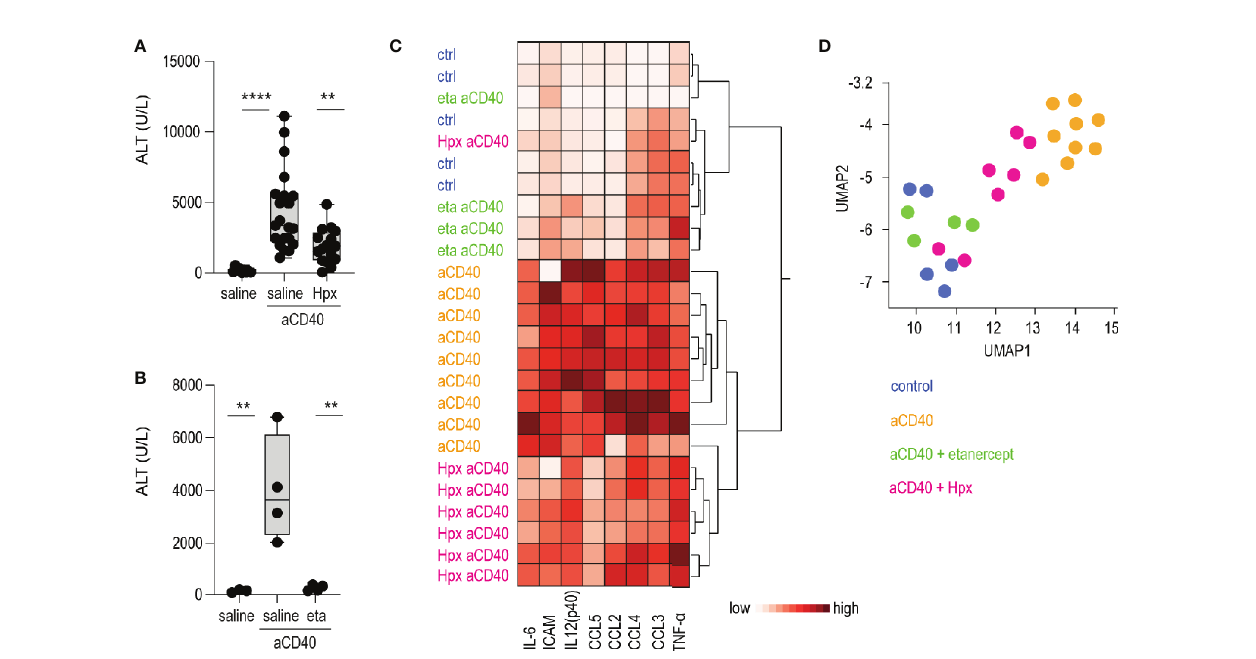
FIGURE 4 | Hemopexin and etanercept treatments as validation of the model. (A) Plasma ALT concentrations from saline and plasma-derived hemopexin (Hpx) treated sickle cell mice dosed or not with anti-CD40 antibody (groups; saline n=12, aCD40 n= 21, hpx aCD40 n=16). (B) Plasma ALT concentrations from saline and etanercept (eta) treated sickle cell mice dosed or not with anti-CD40 antibody (n=4). (C) Hierarchical clustering analysis of plasma cytokines from saline, hemopexin (Hpx), etanercept (eta) dosed sickle cell mice, treated or not with anti-CD40 antibody (white=low expression, red=high expression) (groups; saline n=5, aCD40 n=9, hpx aCD40 = 7, eta aCD40 n=4). (D) UMAP plot showing color-coded plasma cytokines from the same groups of animals as in (C) **** p < 0.0001, ** p < 0.01 ANOVA with Tukey ’ s post hoc test for (A, B)